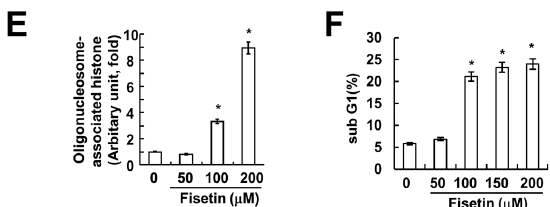
Figure 1. Fisetin induces apoptosis in human renal carcinoma Caki cells. ( A , B ) Caki cells were treated with the indicated concentrations of fisetin for 24 h; ( A ) The sub-G1 fraction was measured using flow cytometry as an indicator of the level of apoptosis; ( B ) The protein expression levels of PARP and actin were determined by western blotting; ( C ) Caki cells and TCMK-1 cells were treated with the indicated concentrations of fisetin for 24 h. The cell morphology was examined using interference light microscopy. The sub-G1 fraction was measured by flow cytometry; ( D , E ) Caki cells were treated with the indicated concentrations of fisetin for 24 h; ( D ) The condensation and fragmentation of the nuclei were detected by 4 ′ ,6 ′ -diamidino-2-phenylindole staining; ( E ) The cytoplasmic histone-associated DNA fragments were determined by a DNA fragmentation detection kit; ( F ) SK-Hep-1 cells were treated with the indicated concentrations of fisetin for 24 h. The sub-G1 fraction was measured using flow cytometry. The values in ( A , C , E , F ) represent the mean ± SD from three independent samples. * p < 0.01 compared to the control.